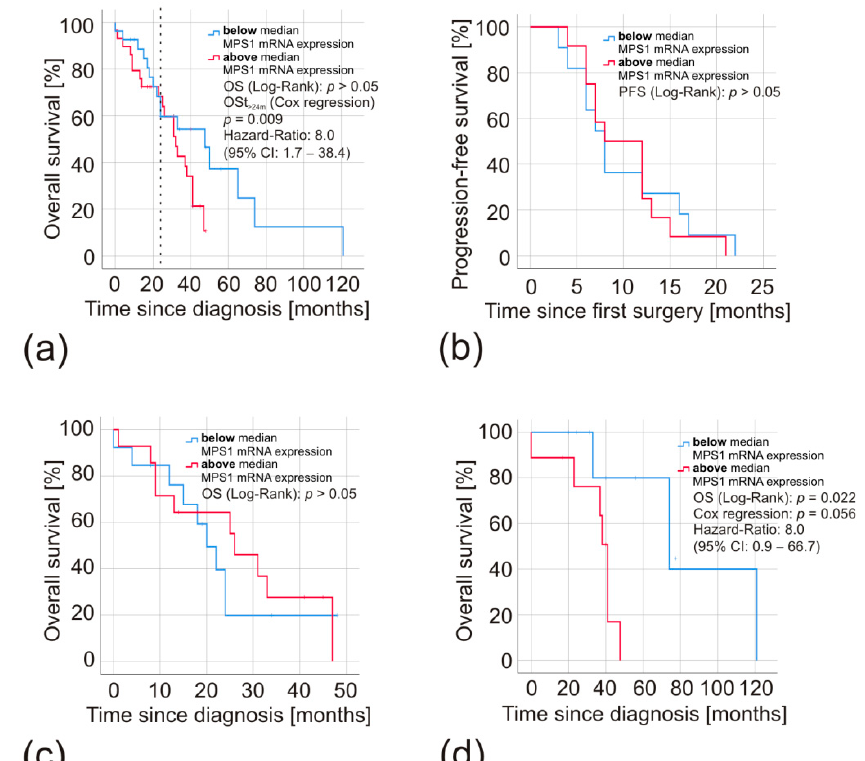
Figure 3. Kaplan–Meier analyses of patients with high and low MPS1 mRNA expression in their gliomas. Survival of patients with MPS1 mRNA expression below (blue) and above (red) the median expression of 49-fold was compared. Hazard ratios and time-dependent effects were calculated by applying the Cox proportional hazards model, p -values by the Log Rank test. ( a ) Overall survival of all glioma patients combined independently of their WHO grade ( MPS1 mRNA expression high n = 27, low n = 29). The dashed line indicates a survival time of 24 months. ( b ) Progression-free and ( c ) overall survival of GBM patients ( MPS1 mRNA expression high n = 12 and n = 14, respectively, low n = 11 and n = 13, respectively). ( d ) Overall survival of patients with IDHmut gliomas ( MPS1 mRNA expression high and low n = 9,